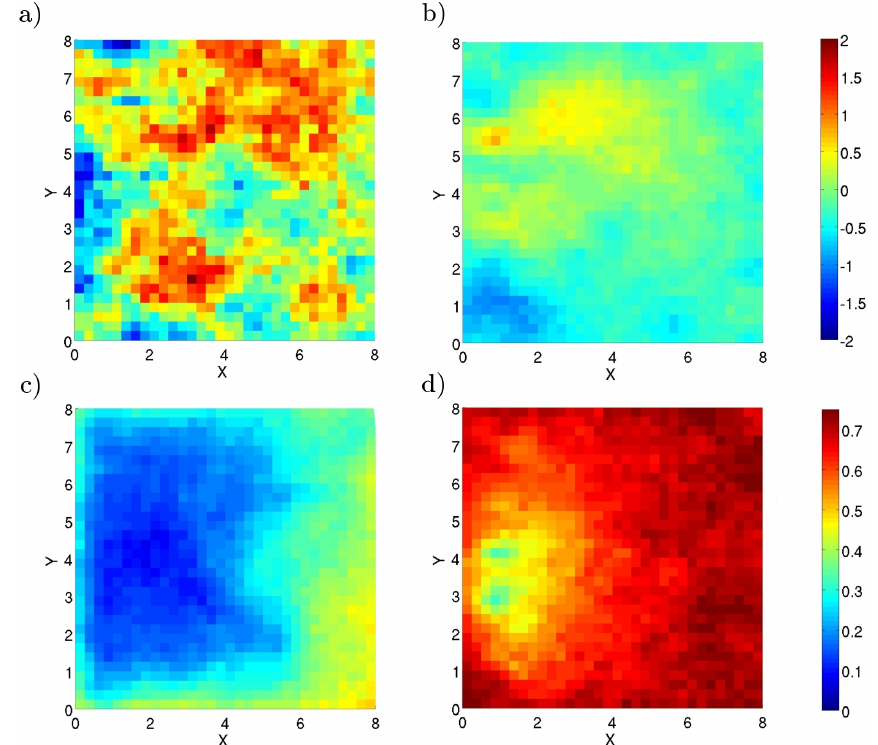
Fig. 3. Scenario 1: log-transformed hydraulic conductivity field retrieved by (a) the EnKF and (b) ES using untransformed concentration data. The color bar indicates log-transformed hydraulic conductivity in ln (L/T ) . (c) and (d) show the estimation variance maps after the inversion for the EnKF and ES, respectively.